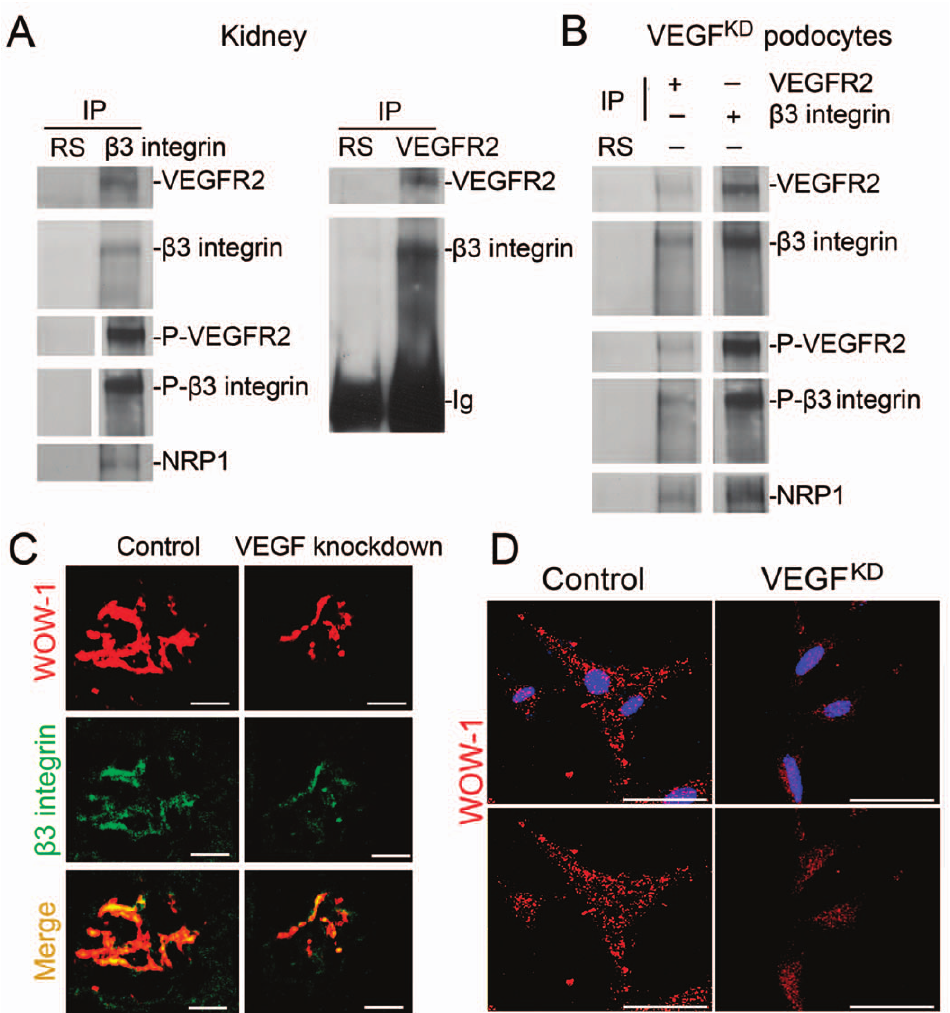
Figure 7. VEGFR2- b 3 integrin-neuropilin-1 interact invivo and in cultured podocytes. VEGF knockdown decreases alpha V beta 3 integrin activity. (A) VEGFR2 - beta 3 integrin - neuropilin1 (NRP1) co-immunoprecipitate in vivo, shown by reciprocal VEGFR2 and beta 3 integrin IP. Negative control is rabbit serum (RS). Immunoprecipitates were blotted with VEGFR2, beta 3 integrin, Y 1175 -VEGFR2, anti S 785 - beta 3 integrin and neuropilin-1 antibodies. (B) VEGFR2 - beta 3 integrin – NRP1 co-immunoprecipitate in cultured podocytes. IPs were performed as described in (A) using VEGF KD podocyte lysates. (C) Dual-immunostaining shows decreased active alpha v beta 3 integrin (WOW-1) and total beta 3 integrin in glomeruli from VEGF knockdown mice. (D) Immunocytochemistry shows decreased active alpha V beta 3 integrin (WOW-1) in VEGF knockdown as compared to control podocytes, blue nuclei (Hoechst 33342). Scale bars=20 m m.